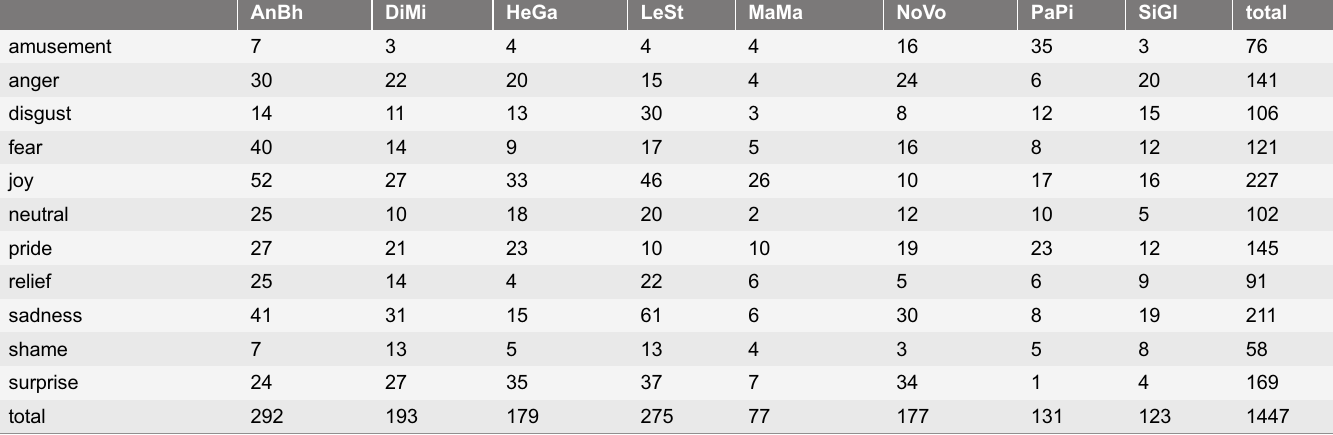
Table 6. Frequencies in the final set of motion sequences across actors (rows) and intended emotion categories